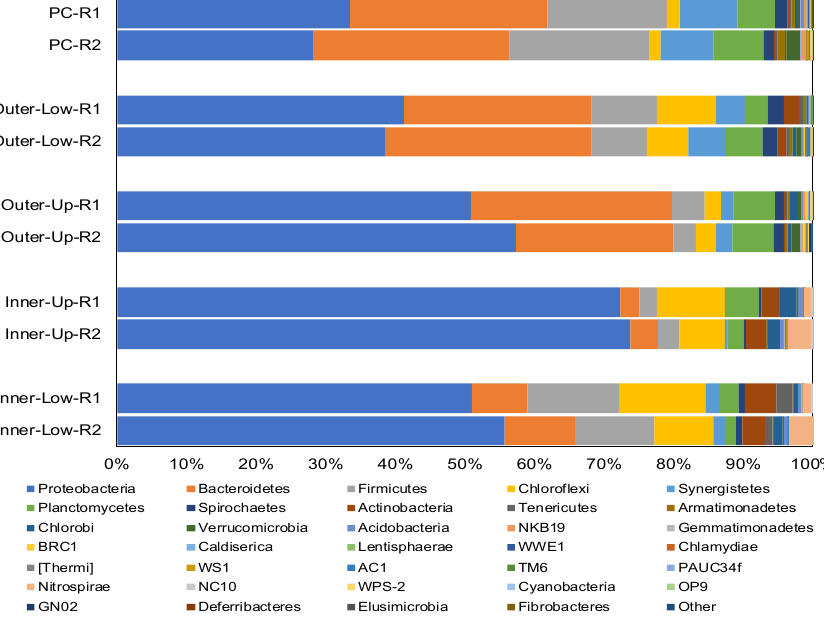
Figure 4. Phylogenetic makeup of the microbial community from different samples of the anodic biofilms from the bioelectrochemical system-trickling filter (BES-TF) reactors R1 and R2. PC: planktonic cells, Outer-Low: Outer biofilm of the lower part of the anode (submerged in wastewater), Outer-Up: Outer biofilm of the upper part of the anode (not submerged in the wastewater), Inner-Low: Inner biofilm of the lower part of the anode (submerged in wastewater), Inner-Up: Inner biofilm of the upper part of the anode (not submerged in the wastewater).